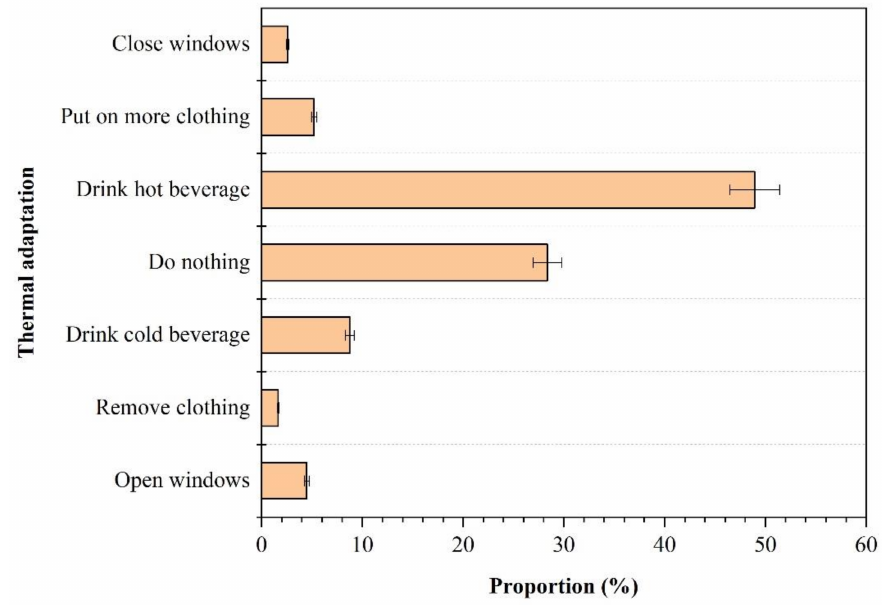
Figure 12. Proportion of patients’ adaptive